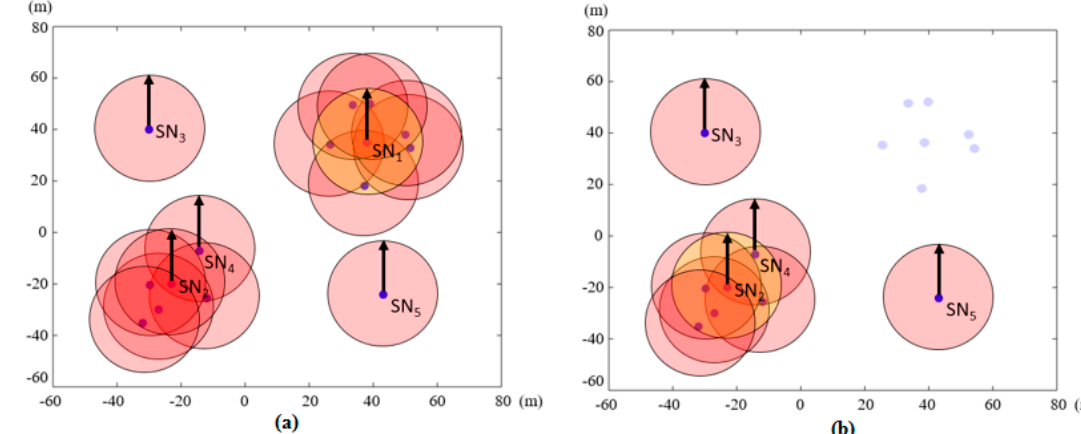
Figure 2. Selection of cluster heads by maximum inclusion criterion: ( a ) inclusion circles, whose centers are at sensor node locations, to obtain cluster heads; and ( b ) sensor nodes in the first cluster are not taken into account for selection of the other cluster heads.